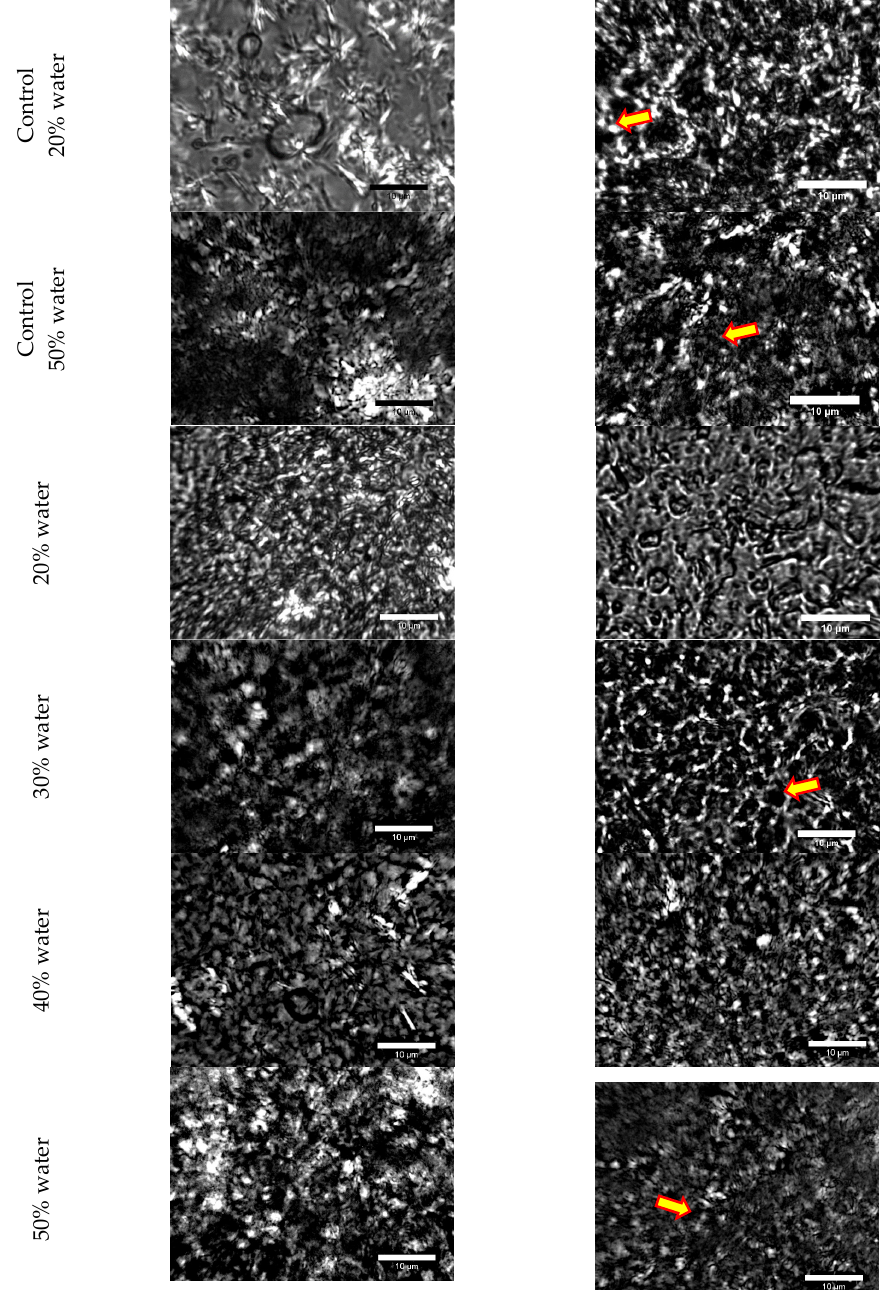
Figure 6. Polarized light with bright-field micrographs of water-in-canola-oil emulsions on day 1 and day 30 for control emulsions without LMP with 20 and 50 wt.% water and for LMP emulsions with 20 to 50 wt.% water. Scale bar 10 μ m. Arrows indicate interfacial fat crystals around the water droplets.